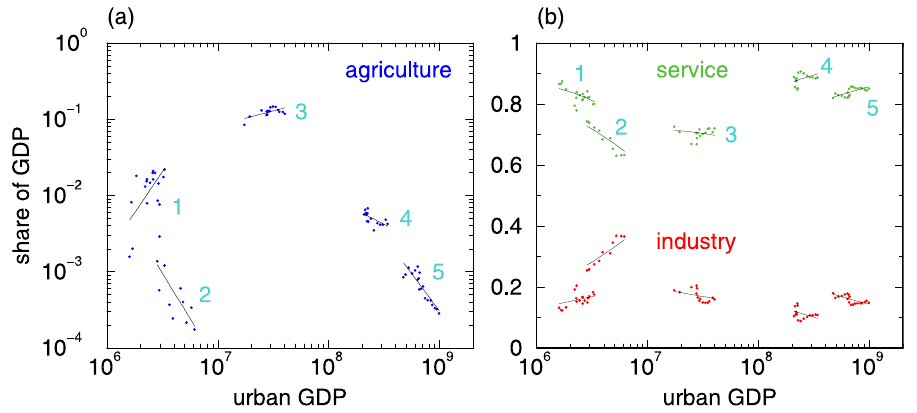
Fig 1. Metropolitan Statistical Area (MSA) examples of sectoral development. (a) Agriculture, a ( g ), as a function of the total urban GDP in log-log representation; (b) industry (bottom), i , and service (top), s , as a function of the total urban GDP in log-linear representation. The MSA are, 1: Great Falls, MT (type A − [96%], GeoFIPS 24500), 2: East Stroudsburg, PA (type B [100%], GeoFIPS 20700), 3: Fresno, CA (type B − [97%], GeoFIPS 23420), 4: Miami-Fort Lauderdale-Pompano Beach, FL (type C [81%], GeoFIPS 33100), and 5: Los Angeles-Long Beach-Anaheim, CA (type A [100%], GeoFIPS 31080). Percentages in square-brackets represent confidence from bootstrapping. Dots represent the data and straight lines stem from the DST model Eqs